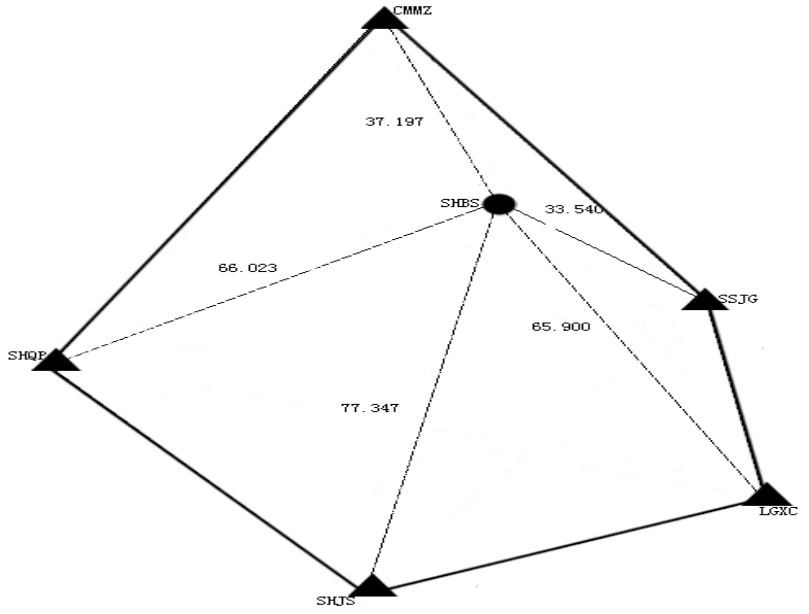
Figure 2. Stations selected from Shanghai CORS and their distribution. Solid triangle